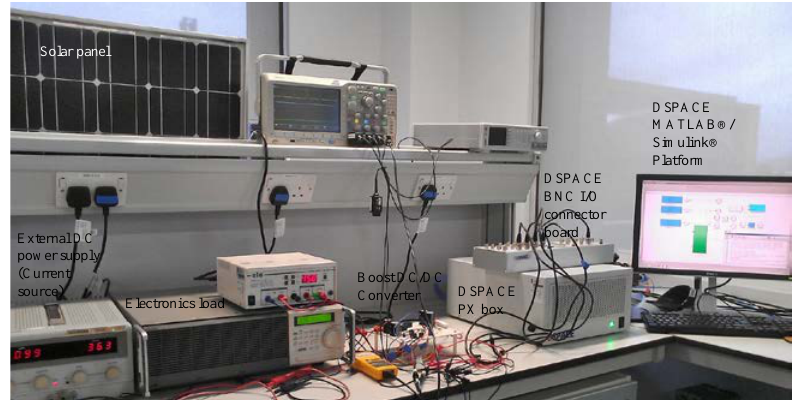
Figure 11 . dSPACE Experimental test system of the MPPT and DC-DC boost converter.